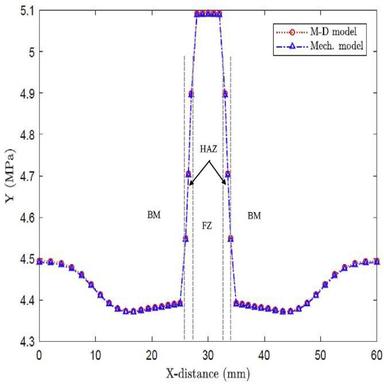
Damage conjugate force Y: comparison between the mechanical model and the M-D model.